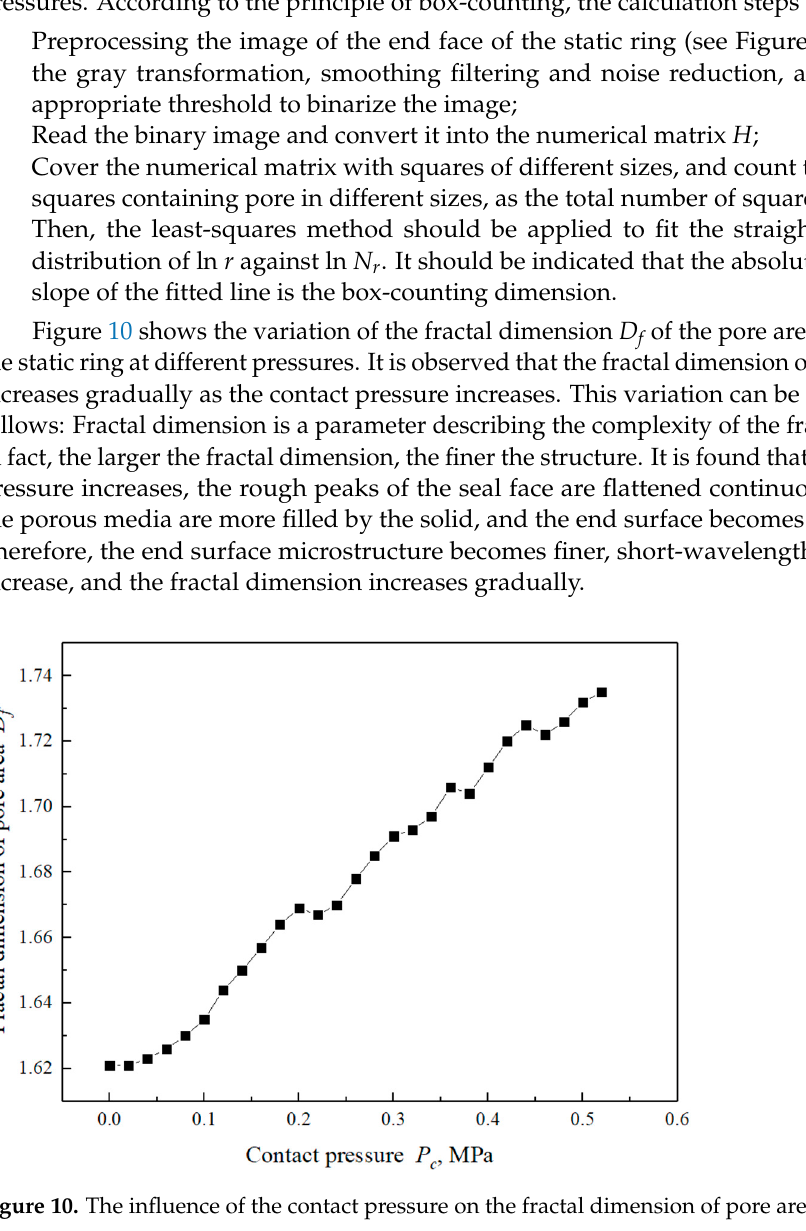
Figure 10. The influence of the contact pressure on the fractal dimension of pore area.